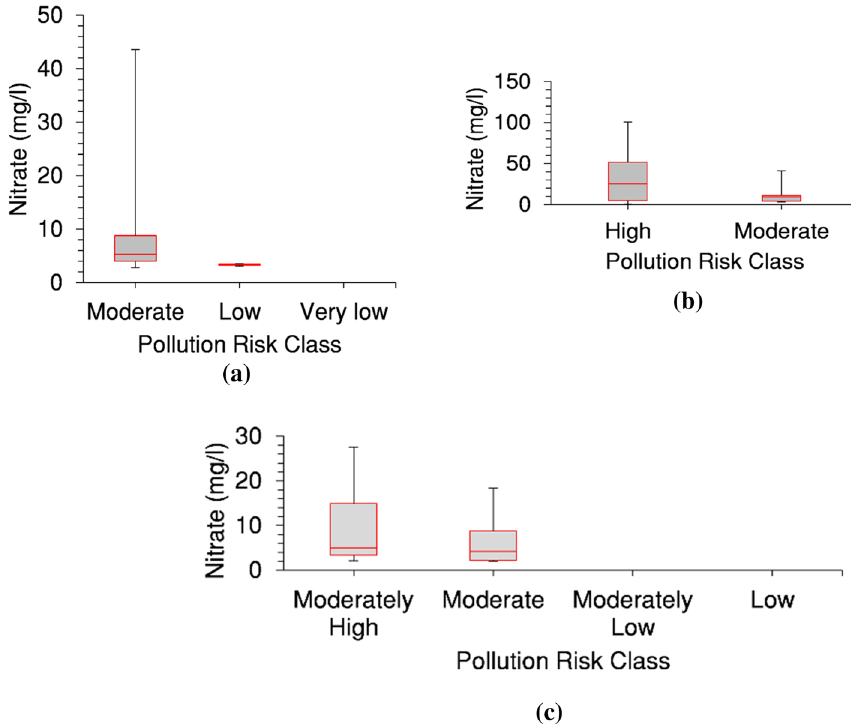
Fig. 5 Box plot showing relationship between ground- water pollution risk classes and groundwater nitrate concentra- tions for the a Vanathavillu,